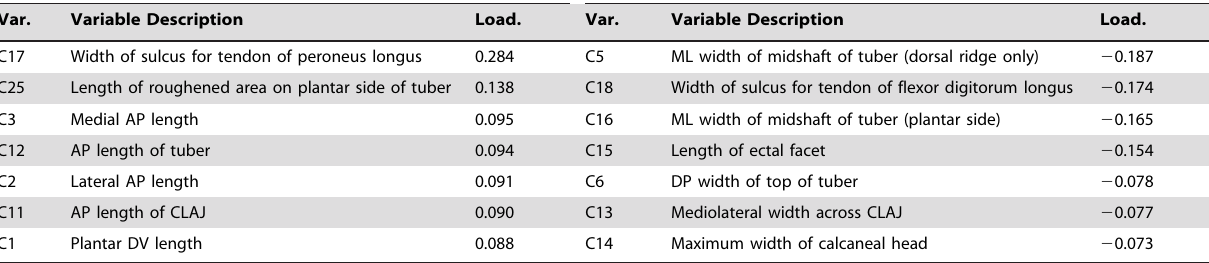
Loading positively on the second component Loading negatively on the second component Var. Variable Description Load. Var. Variable Description